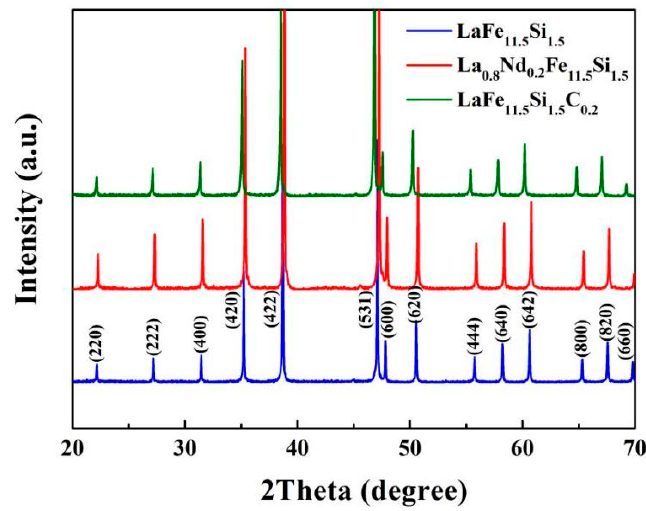
Figure 1. XRD patterns of LaFe 11.5 Si 1.5 , La 0.8 Nd 0.2 Fe 11.5 Si 1.5 , and LaFe 11.5 Si 1.5 C 0.2.